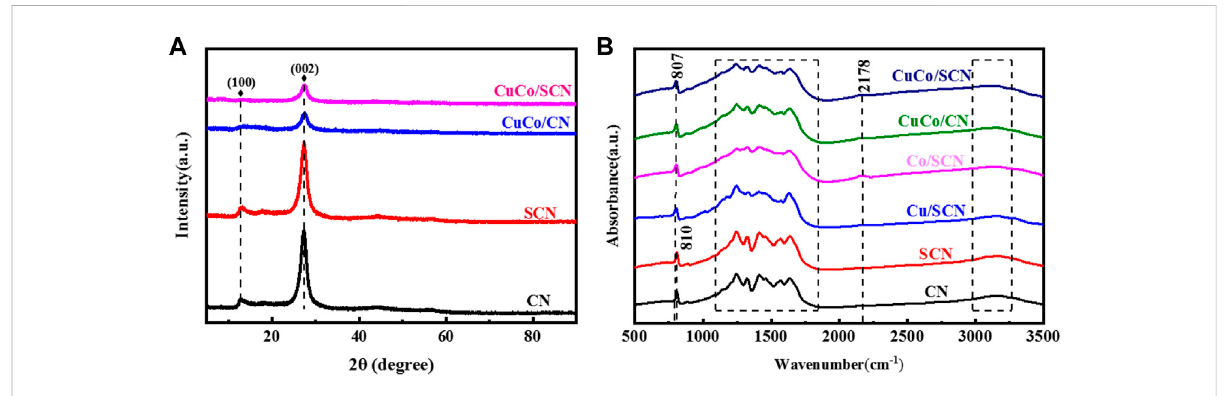
FIGURE 5 (A) XRD patterns and (B) FTIR patterns of the